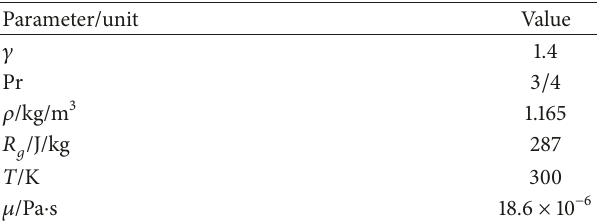
Table 1: Calculating parameters for case shown in Figure 7.